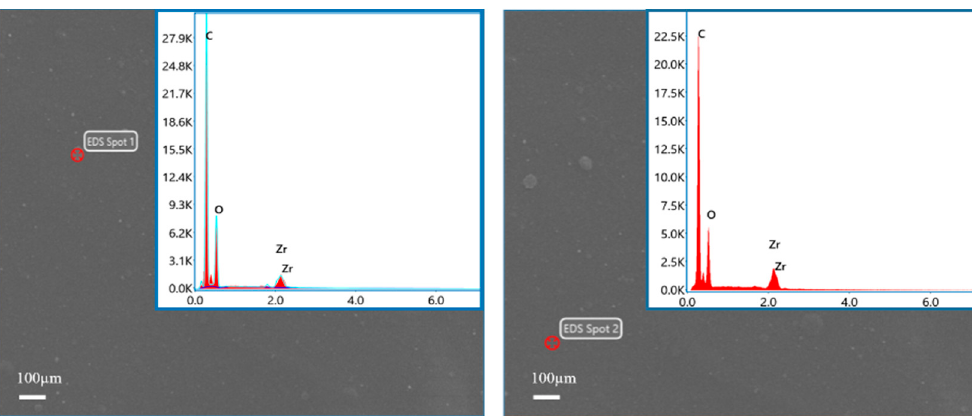
Figure 9. EDs spectrum of 1 wt.% ZrO 2 /BCM.